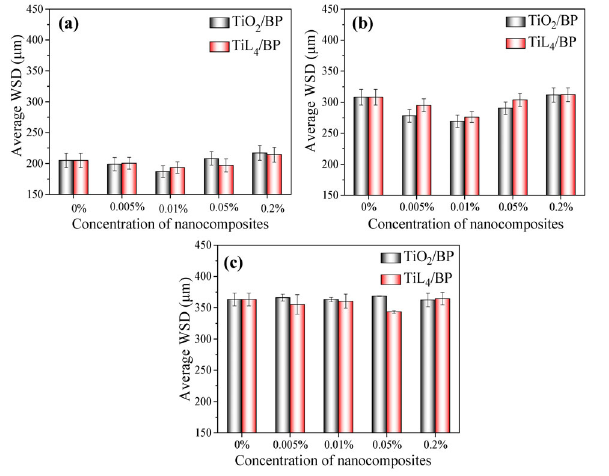
Fig. 5 Average WSD of the upper ball under different loads: (a) 8 N, (b) 20 N, and (c) 30 N.